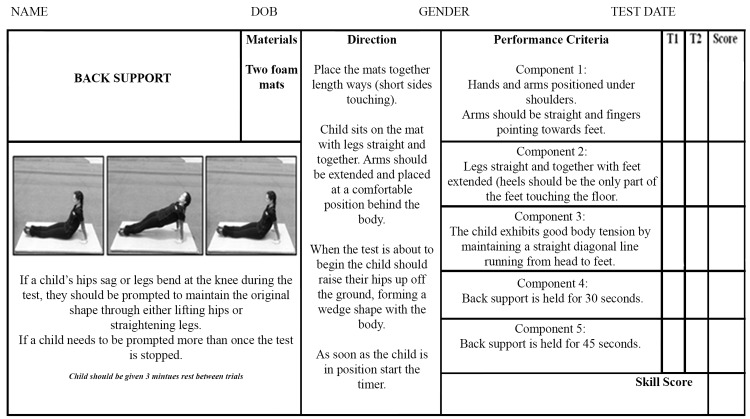
Back-support scoresheet.